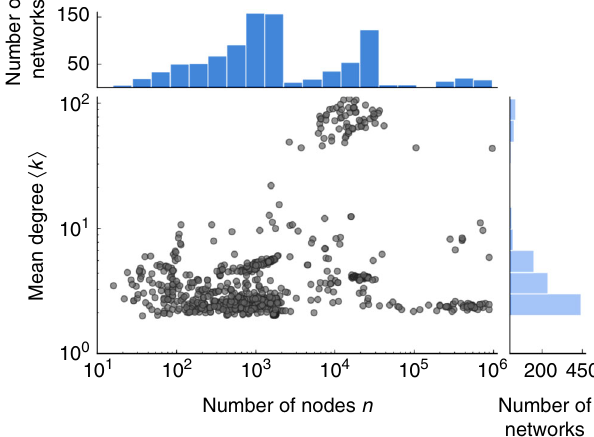
Fig. 1 Mean degree h k i as a function of the number of nodes n . The 928 network data sets in the corpus studied here vary broadly size and density. For data sets with more than one degree sequence (see text), we plot the median of the corresponding set of mean degrees